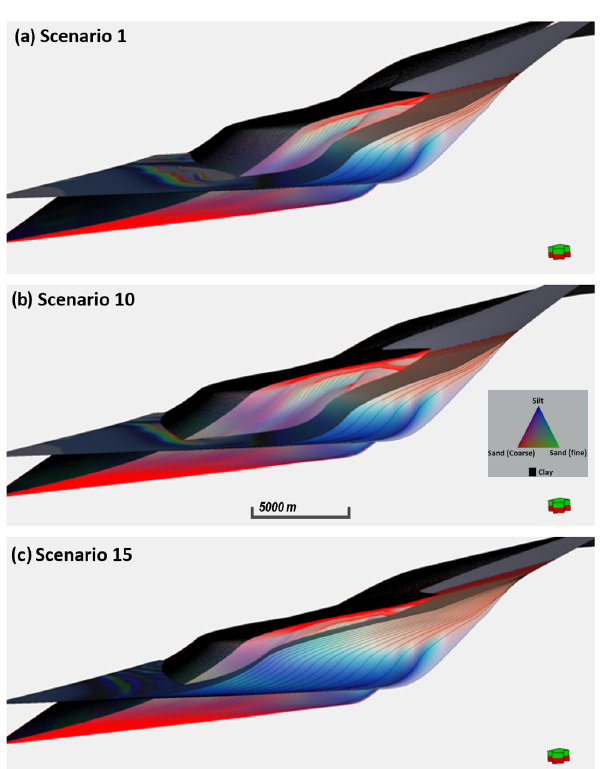
Figure 6. Example of stratigraphic simulation scenarios from which the “best-fit” model was selected. Panel (a) involves the use of equal proportions of sediment supply, a relatively low subsidence rate, and low water depth; panel (b) applies a high proportion of fine sand and silt (70%) in the sediment mix, abrupt changes in subsidence rate, and a relatively high sea level; panel (c) involves very high proportions of fine sand and silt (80%), a steady rate of subsidence and uplift in the sediment source area, and a relatively low water